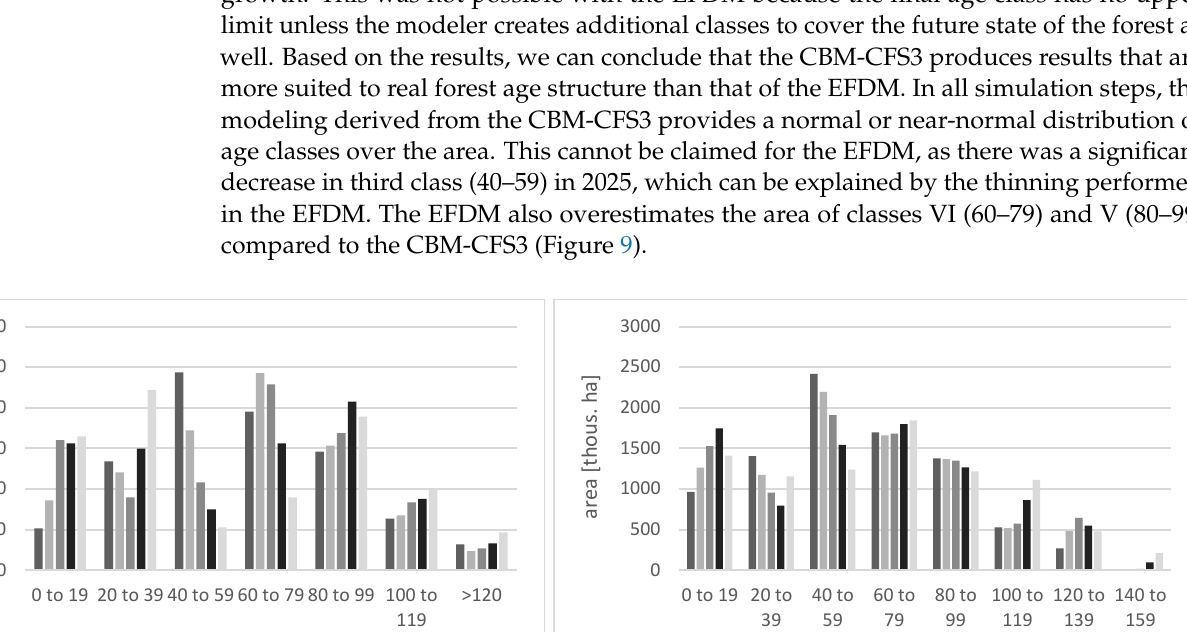
Figure 8. Total growing biomass calculated by both tools, reported in t.C. 106 (on the left ) and t.C.*ha − 1 (on the right ). EFDM projections represented by dashed line, CBM-CFS3—solid line.